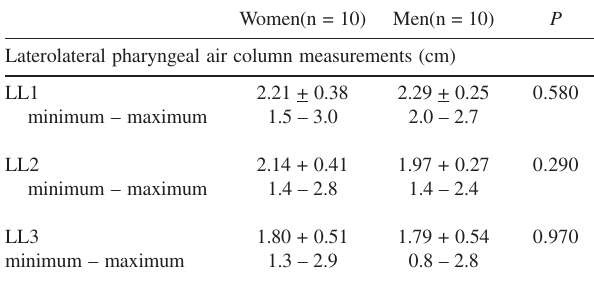
Table 3 - Pharyngeal column cross-sectional linear measurements in healthy men and women